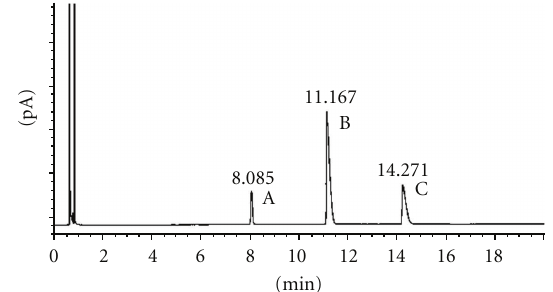
Figure 3: Chiral GC analysis of the trans - S , S -1,2-cyclohexanediol acetates: (A) trans - S , S -1,2-cyclohexanediol diacetate; (B) trans - S , S - 2-hydroxycyclohexyl acetate; (C) trans - S , S